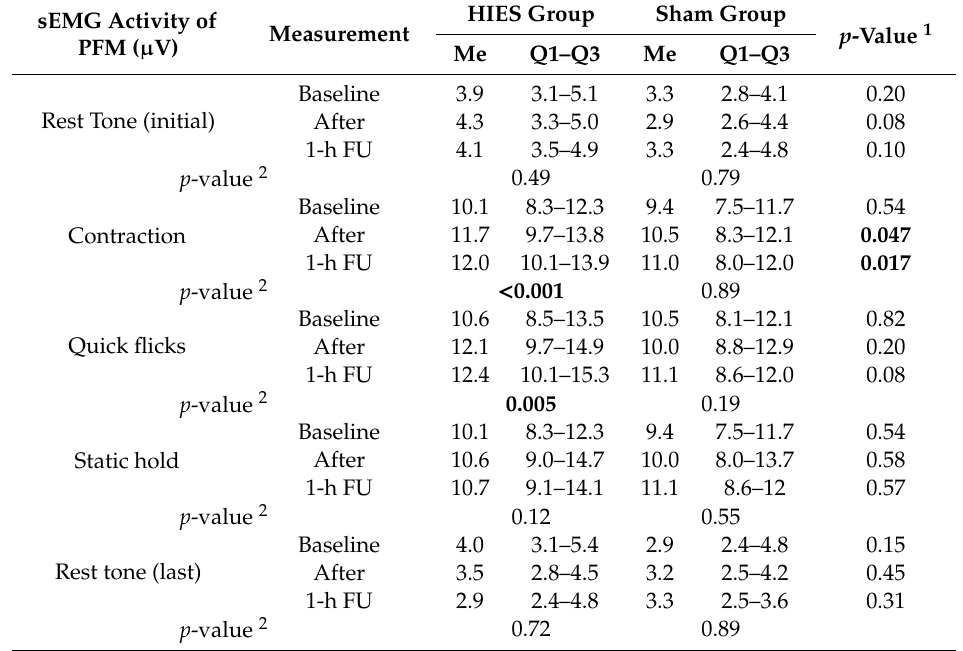
Table 2. Intergroup and intergroup comparison of the sEMG results for the pelvic floor muscle (PFM) in the HIES and sham groups of